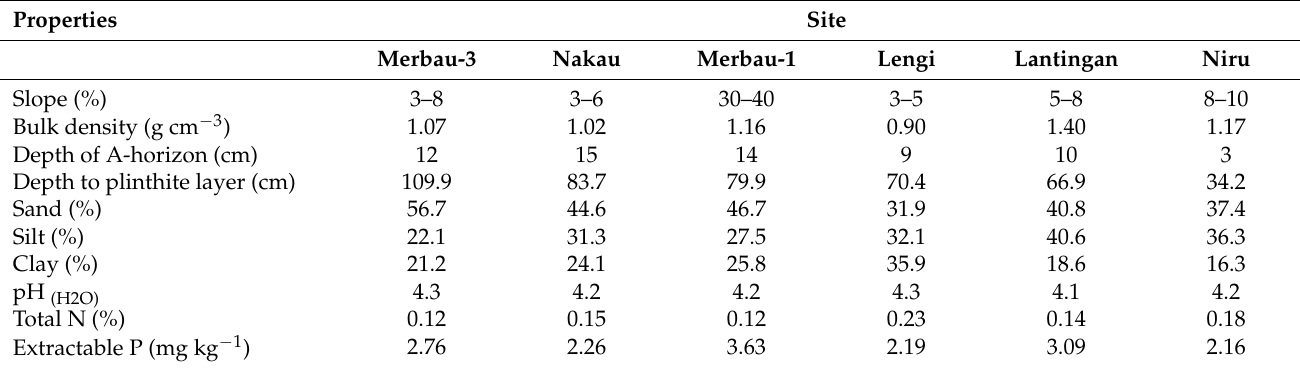
Table 1. Soil profile features and properties of 0–10 cm layer, at sites where responses to P were tested (see Figure 5).